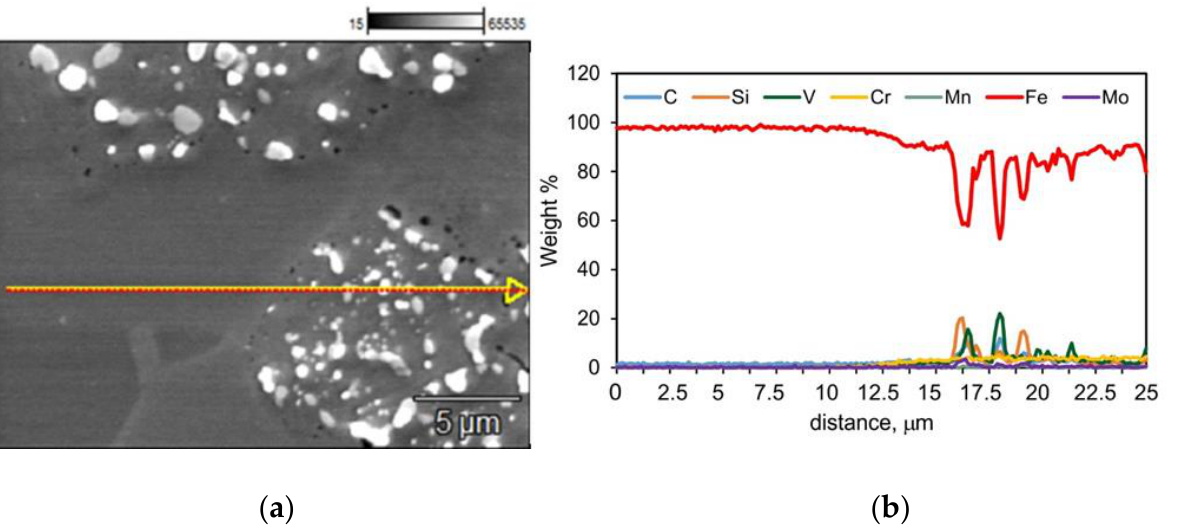
Figure 13. Microstructure of spark plasma sintered T15+50Fe materials, ( a ) microstructure, ( b ) linear analysis of element distribution.